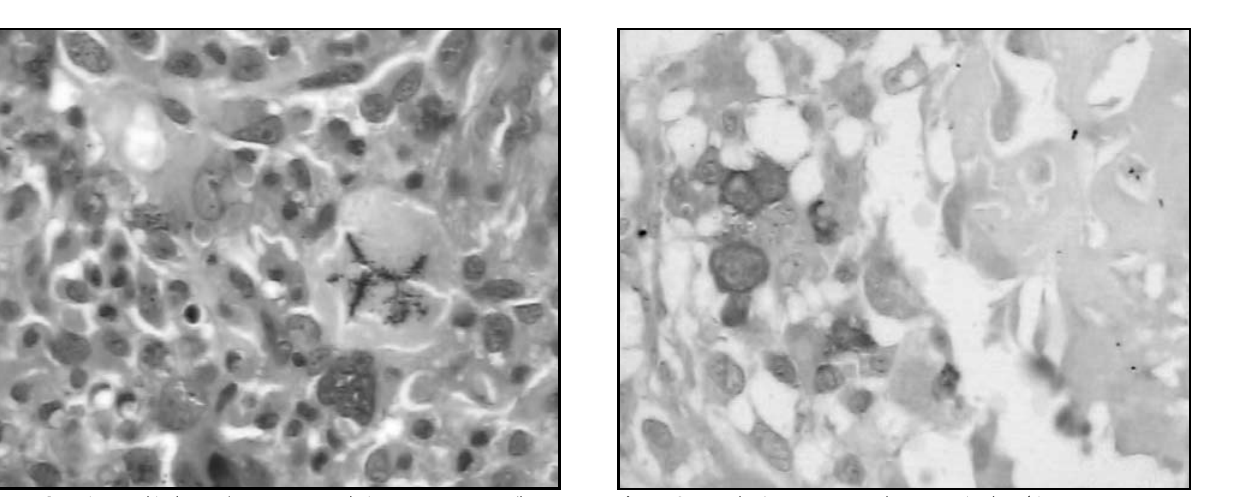
Figura 1 – Mitose multipolar: parâmetro para anaplasia em osteossarcoma (hema- toxilina-eosina [HE] 400x)